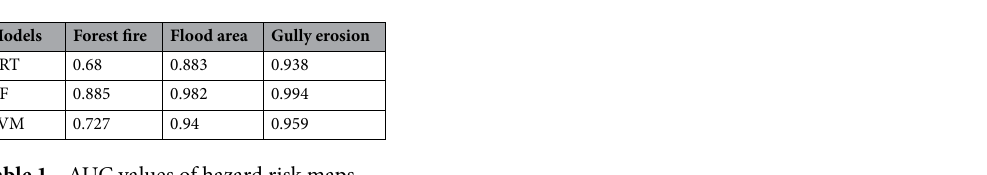
Table 1. AUC values of hazard risk